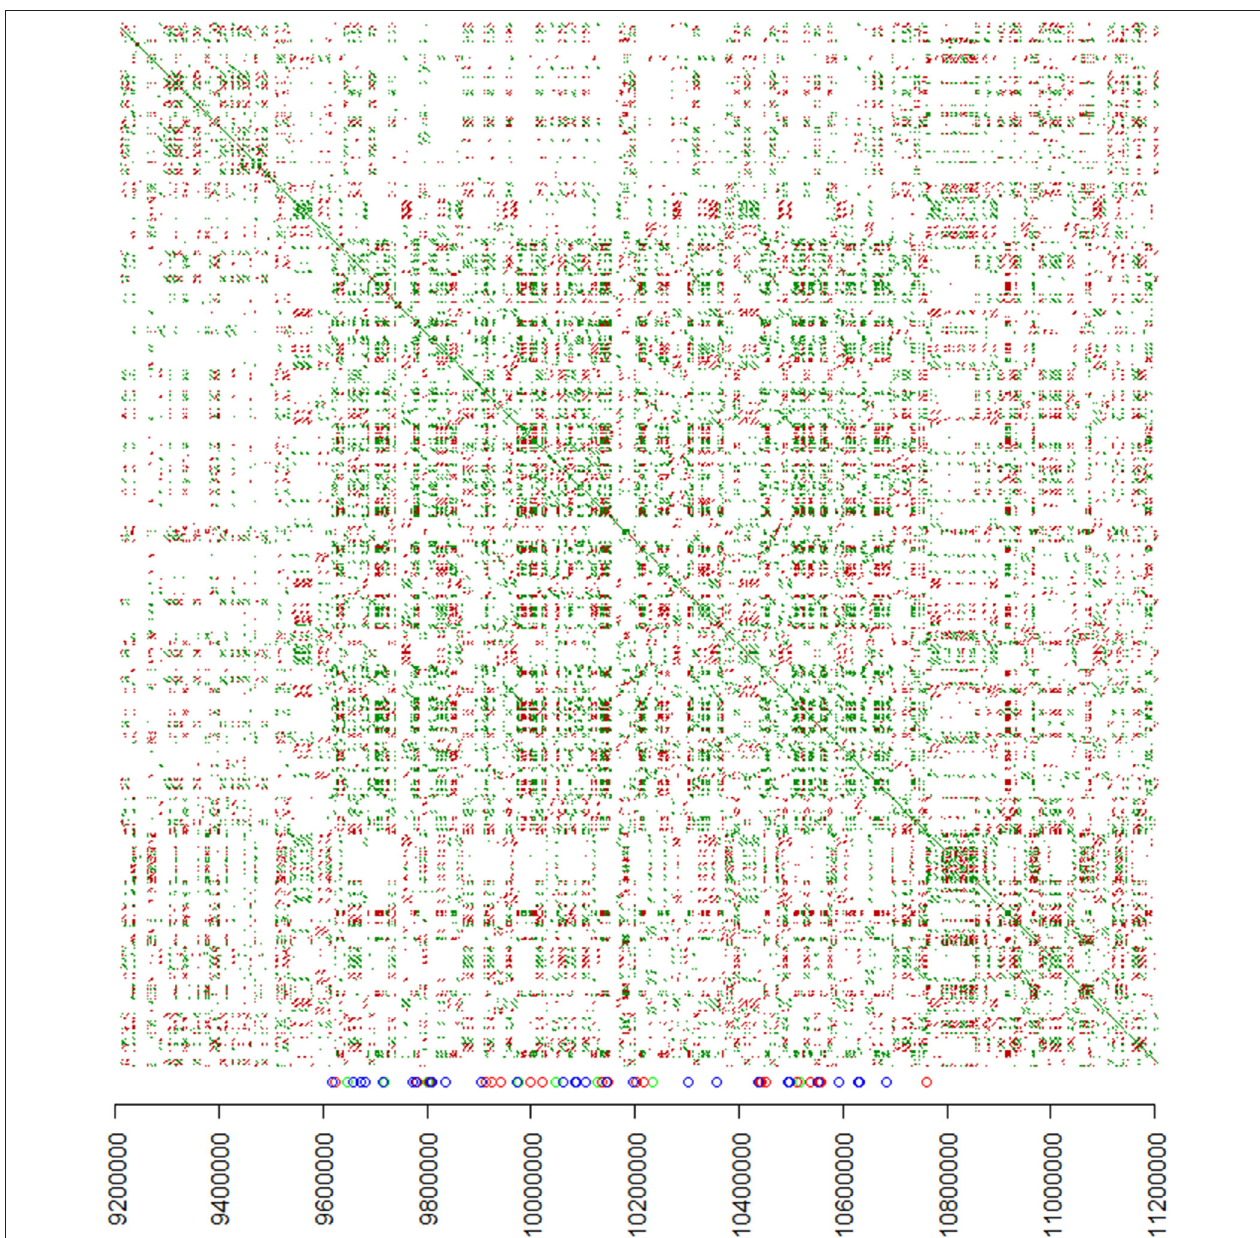
FIGURE 3 | Structure of the PME repeat region in W22. A dot plot was constructed by plotting sequence matches with the indicated coordinates from the W22 chromosome 4 genomic sequence on both axes. Green dots indicate matching sequences on the forward strand and red dots indicate matching sequences on the reverse strand. On the X-axis, blue, green, and red circles indicate the positions of full-length, medium length, and short PME-like sequences,